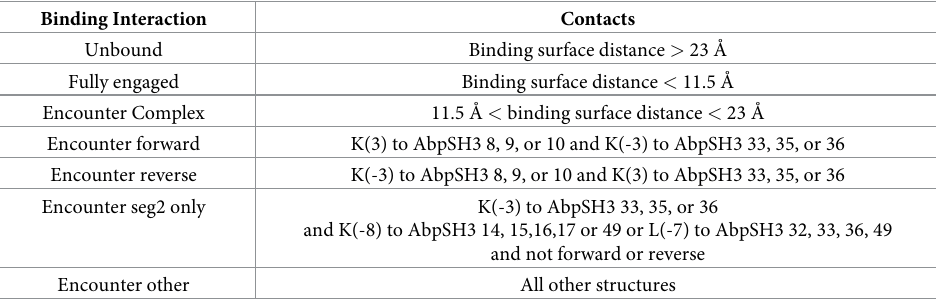
Table 2. Categories in binding